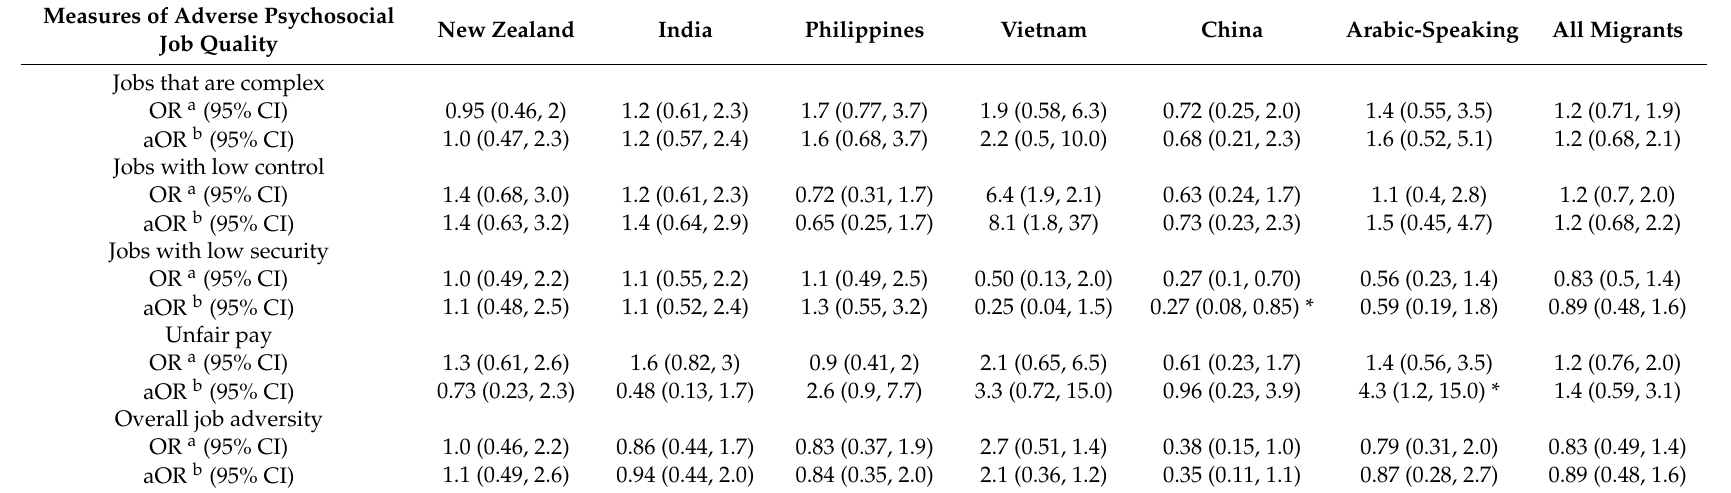
Table 4. The likelihood of having a mental health problem by the interaction between country of birth and psychosocial job quality in the Migrant Worker I and Migrant Worker II surveys with Australian-born workers as the reference